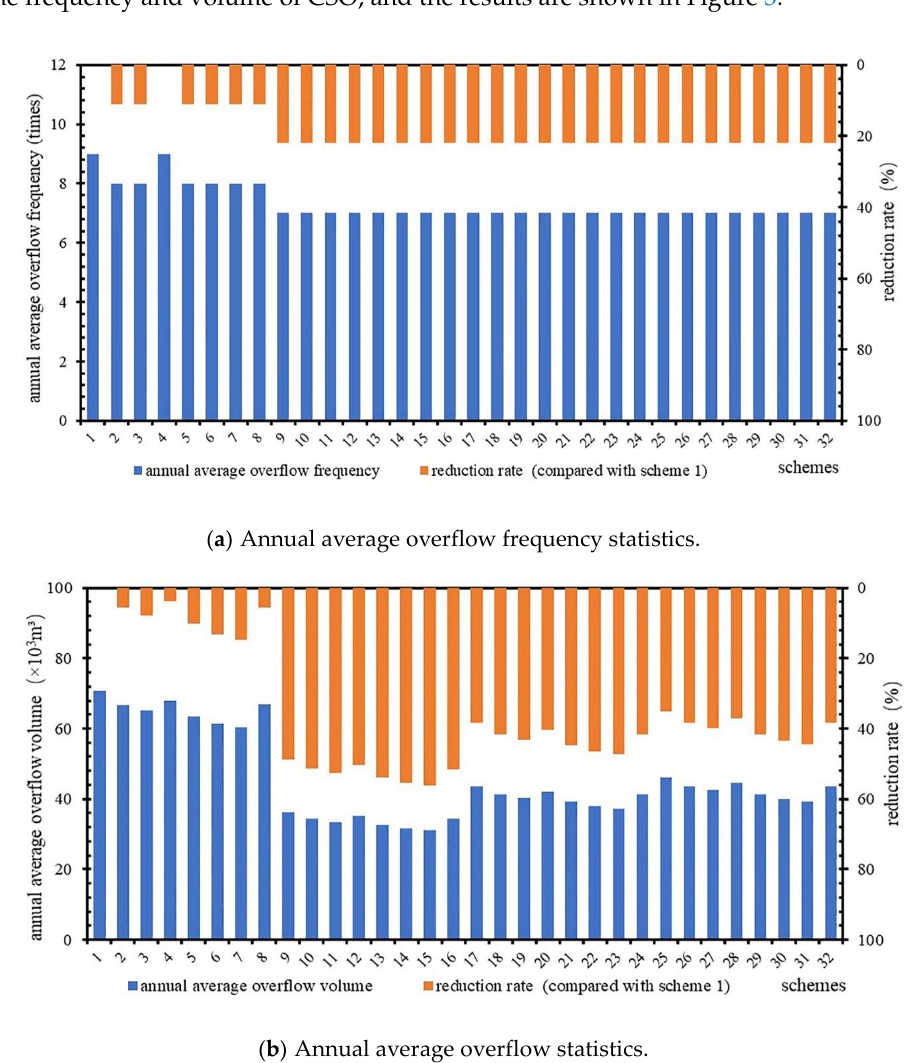
Figure 3. Simulation results of scheme without extra storage tanks (source + midway).